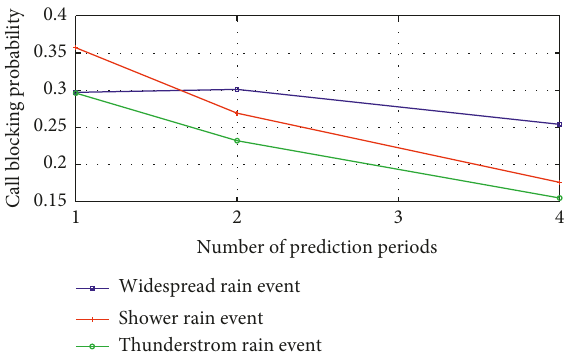
Figure 7: Comparison of call blocking probability.